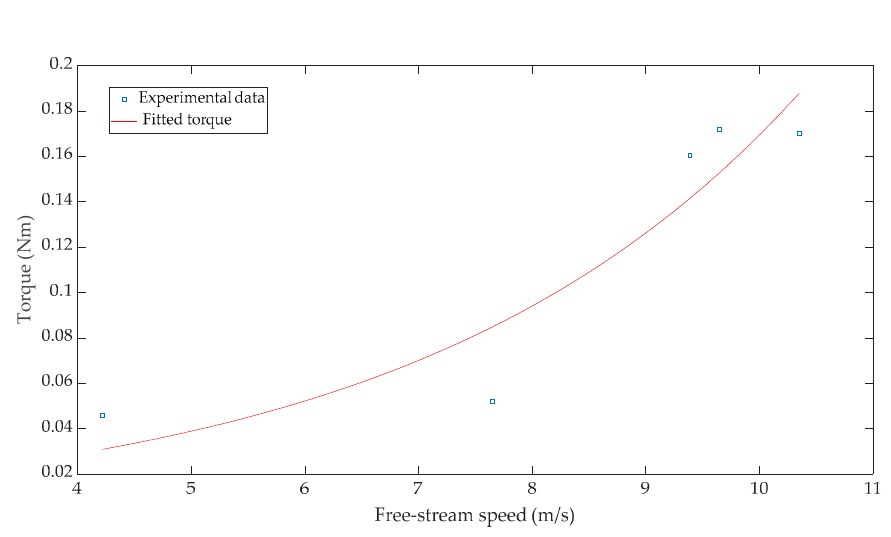
Figure 7. Measured torque as a function of the free-stream speed.